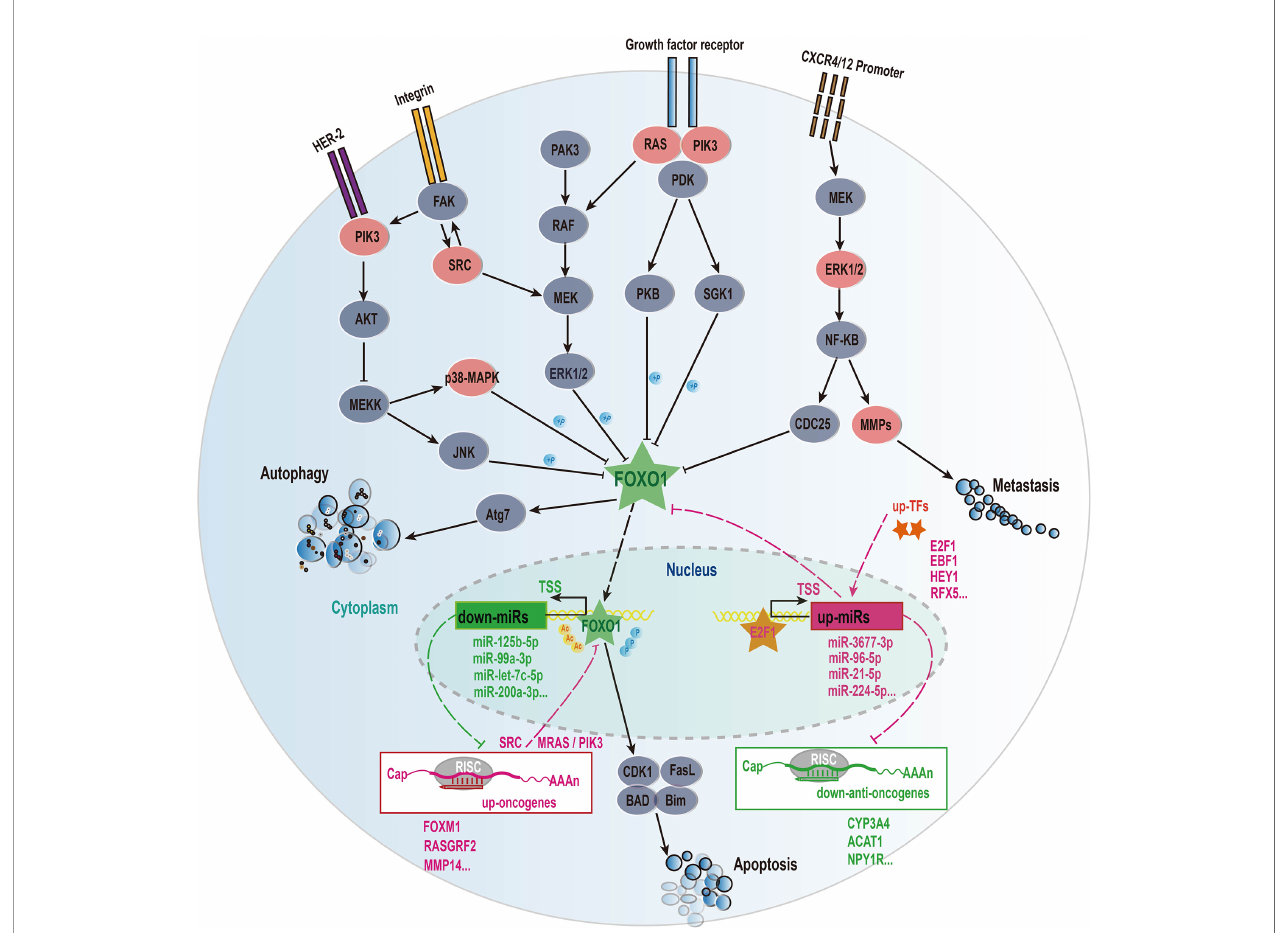
FIGURE 6 | The mechanism of transcription factors and miRNAs interaction affecting the progression of HCC disease. These solid lines represent regulatory relationships and signal pathways that have been experimentally veri fi ed, and the dotted lines represent our results of bioinformatics analysis. The molecules involved in the signaling pathway refer to the gene family such as PIK3 family, RAS family, but not the speci fi c gene name. Sharp arrows represent activation and fl at arrows represent inhibition. Red represents up-regulated genes and green represents down-regulated genes the difference